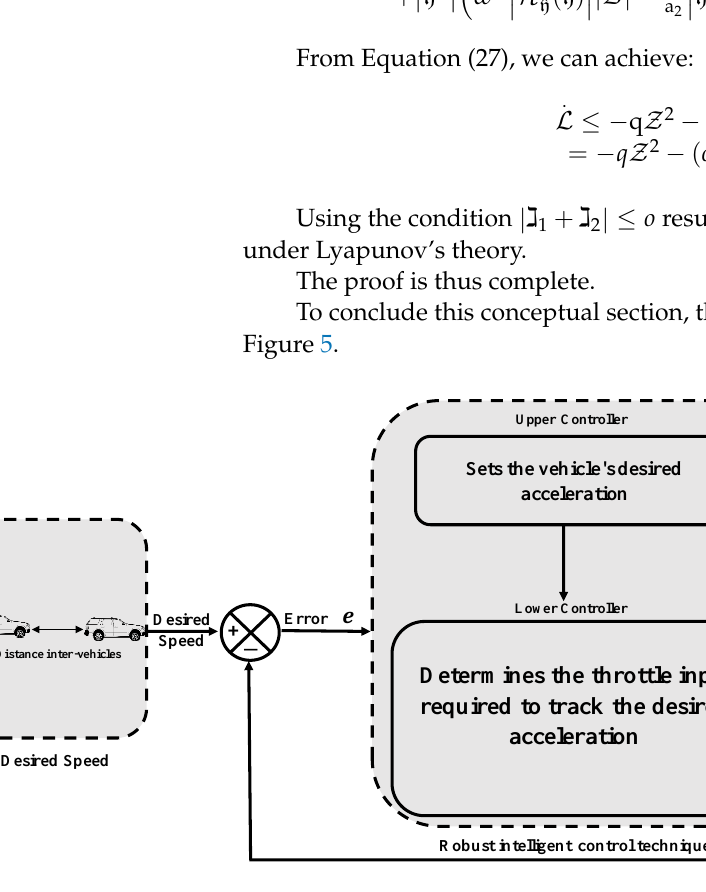
Figure 5. The overall strategy that is suggested.